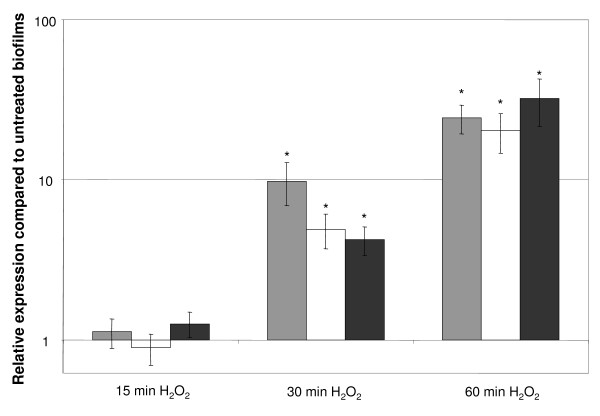
Effect of treatments with H2O2 on the expression of three selected BcepMu prophage genes. The expression of BCAS0543 (BcepMu12; grey bars), BCAS0546 (BcepMu9; white bars) and BCAS0547 (BcepMu8; black bars) in the H2O2-treated biofilms is compared with the expression observed in the untreated biofilms. Error bars represent SEM. *: significant upregulation in treated biofilms compared to untreated biofilms (p < 0.05).